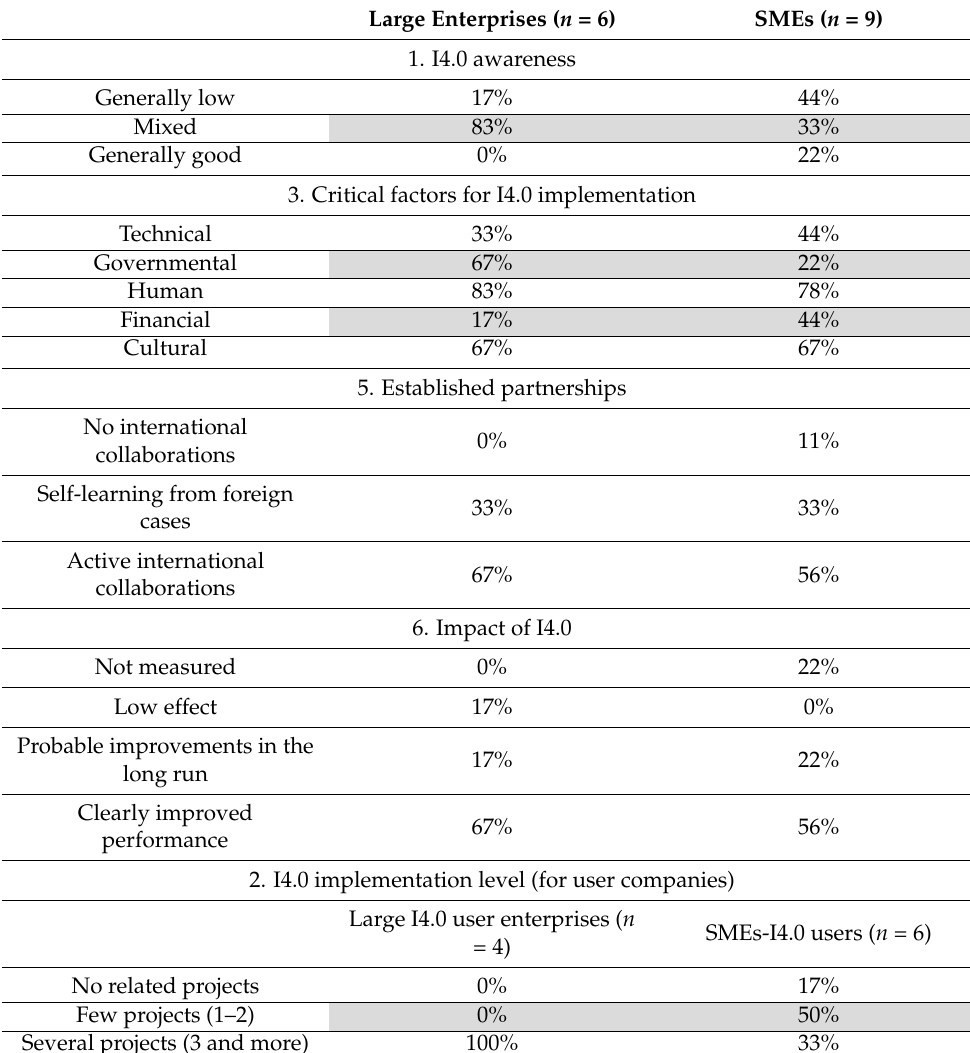
Table 4. Comparative analysis: large enterprises vs.